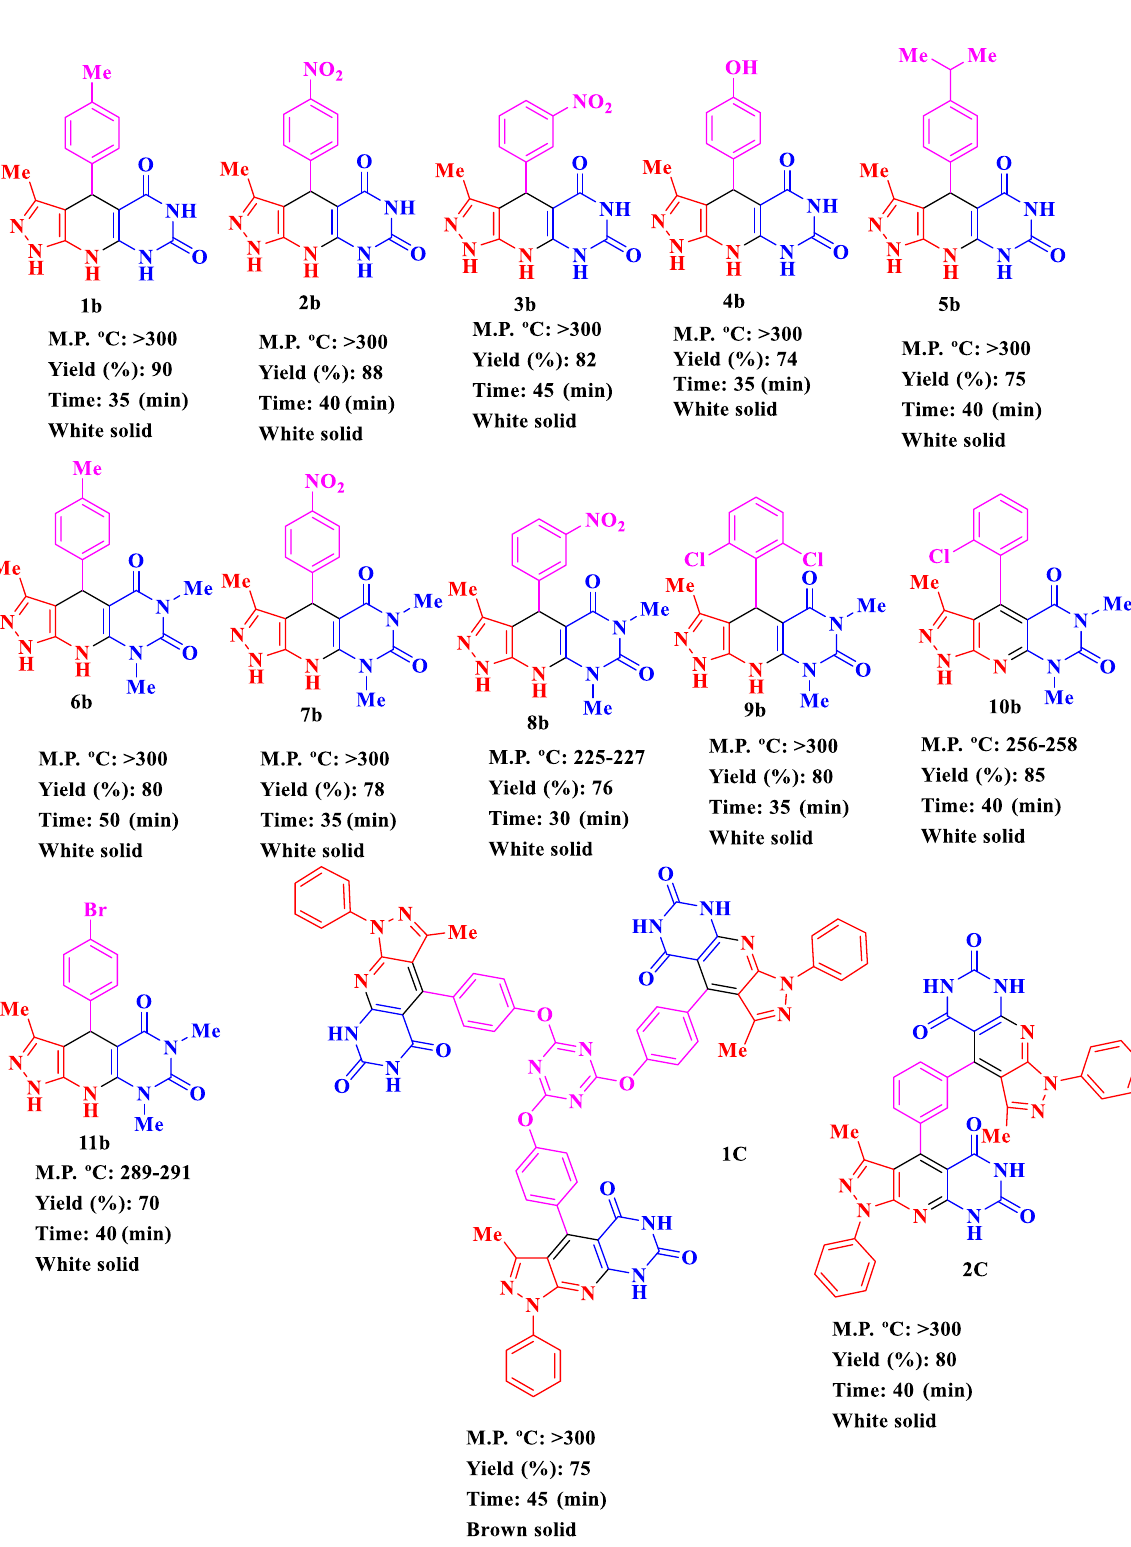
Table 2. Synthesis of ( a ) 3-methyl-1,4-diphenyl-1,8-dihydro-5 H -pyrazolo[4 ′ ,3 ′ :5,6]pyrido[2,3- d